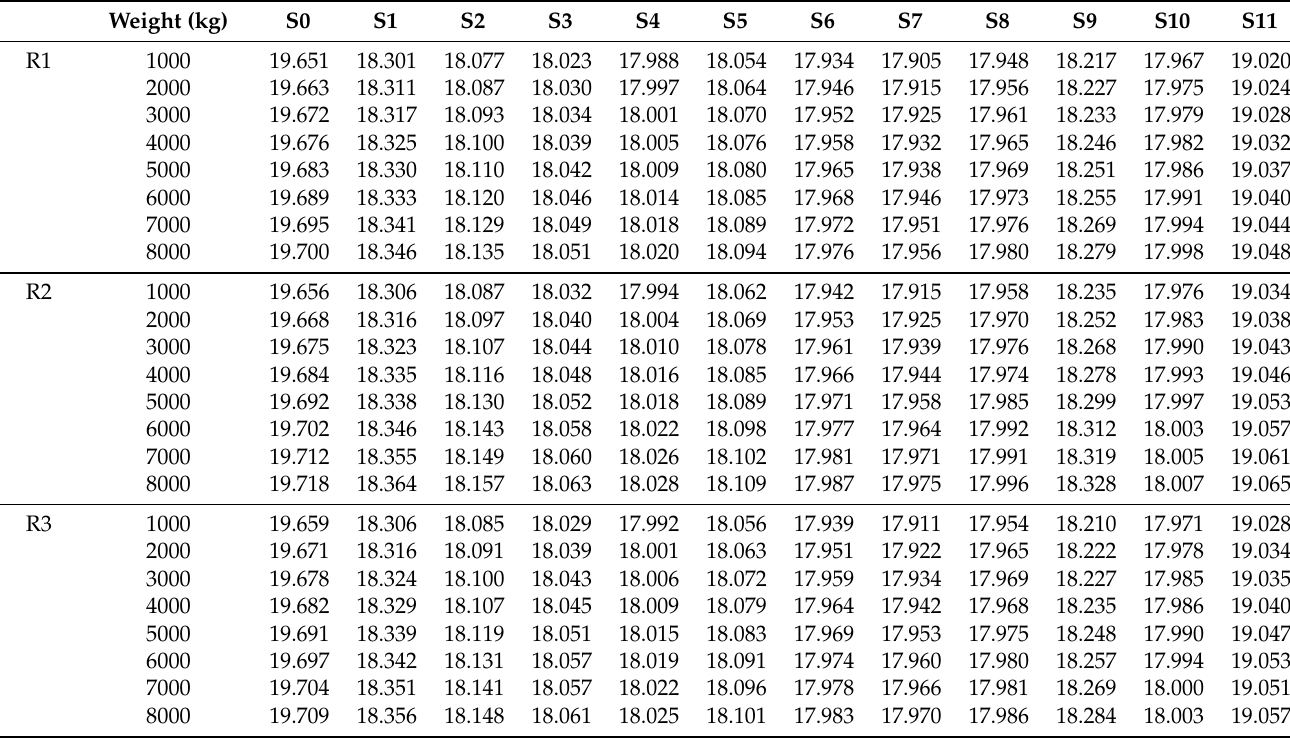
Table 6. Plantar insole—foot size 43 (27 cm)—higher loads.